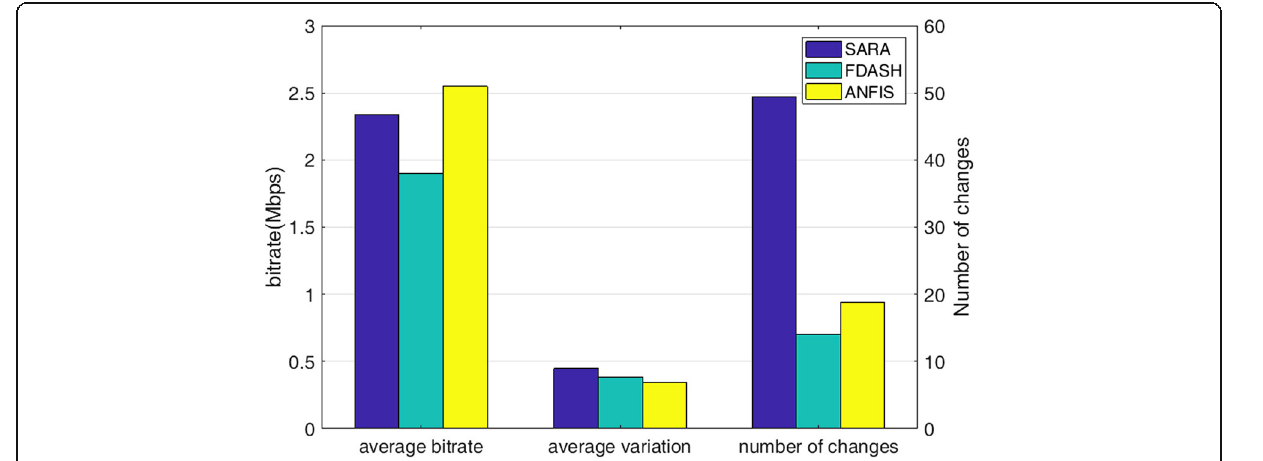
Figure 4 represents the fuzzy membership function based on the trained premise parameters. Figure 5 repre- sents a comparison of the streaming results applying trained ANFIS to a few parts of the training data. In Fig. 5, the orange line indicates the link capacity set in the point-to-point link network, the green line indicates the bit rate training data, and the red line indicates the bit rate determined using the trained ANFIS. Although the red and green lines are not perfectly matched, they exhibit similar shapes and request similar bit rate values.